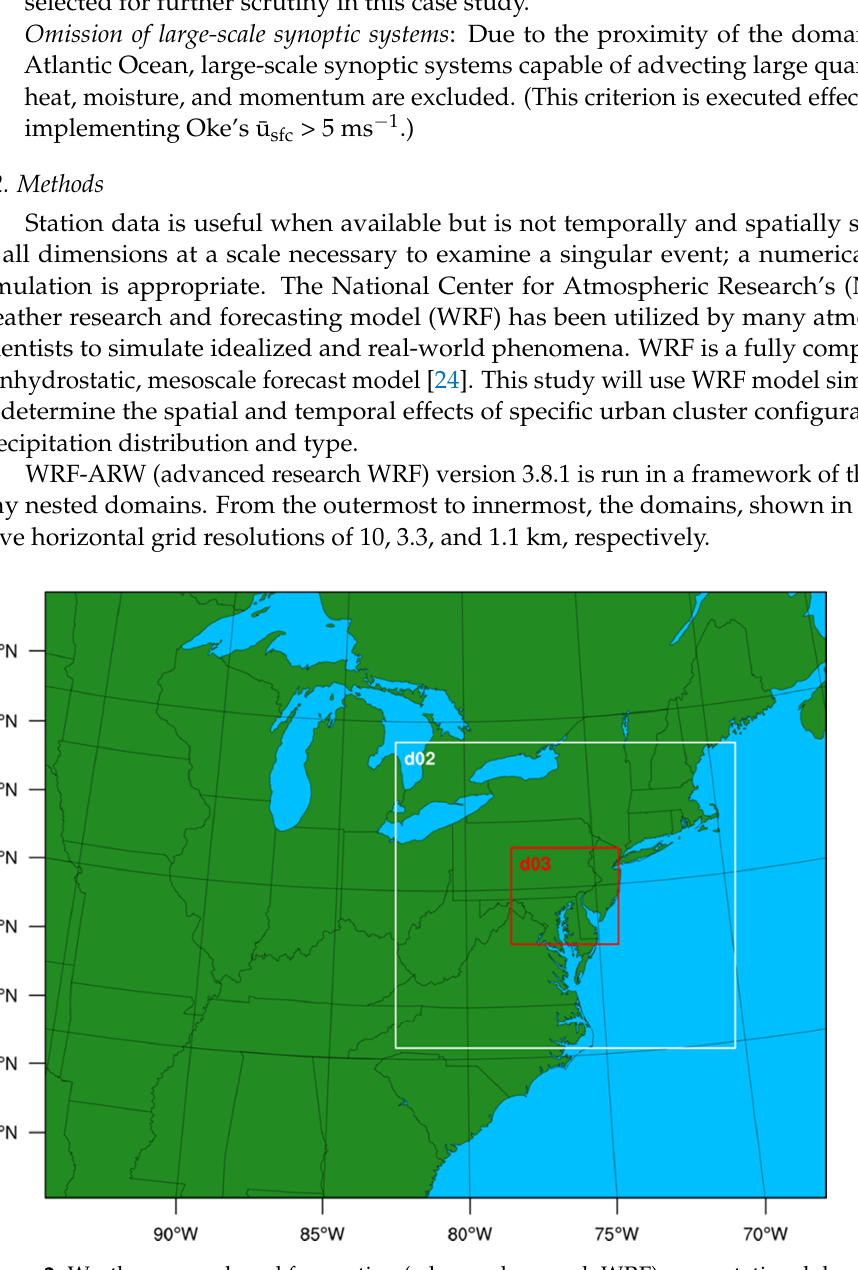
Figure 2. Weather research and forecasting (advanced research WRF) computational domains. The outer domain extends the edge of the graphic and has a horizontal resolution of 10 km. The second and third domains have resolutions of 3.3 km and 1.1 km, respectively.